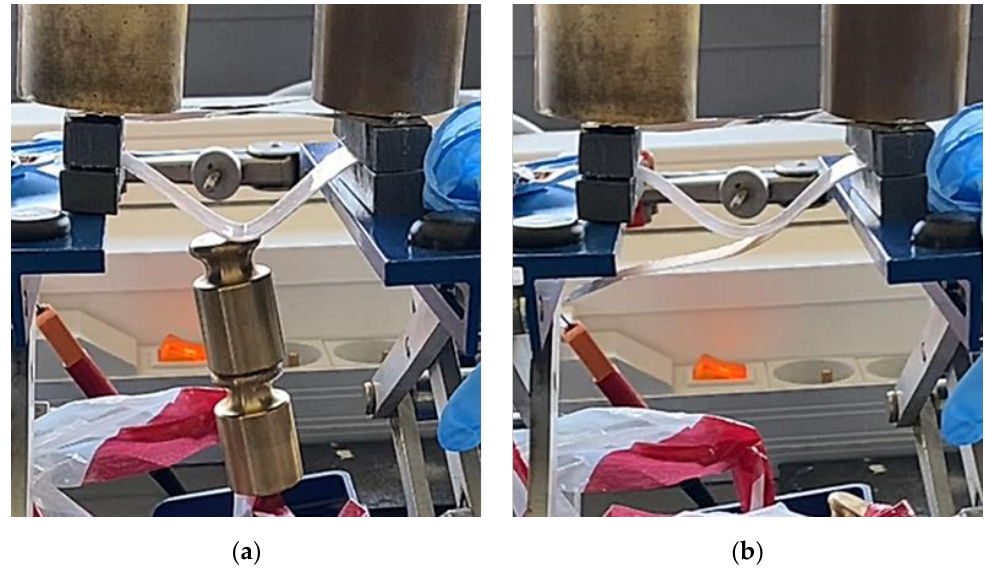
Figure 7. Pictures of the experimental setup where the input voltage is ( a ) ON; and ( b ) OFF.